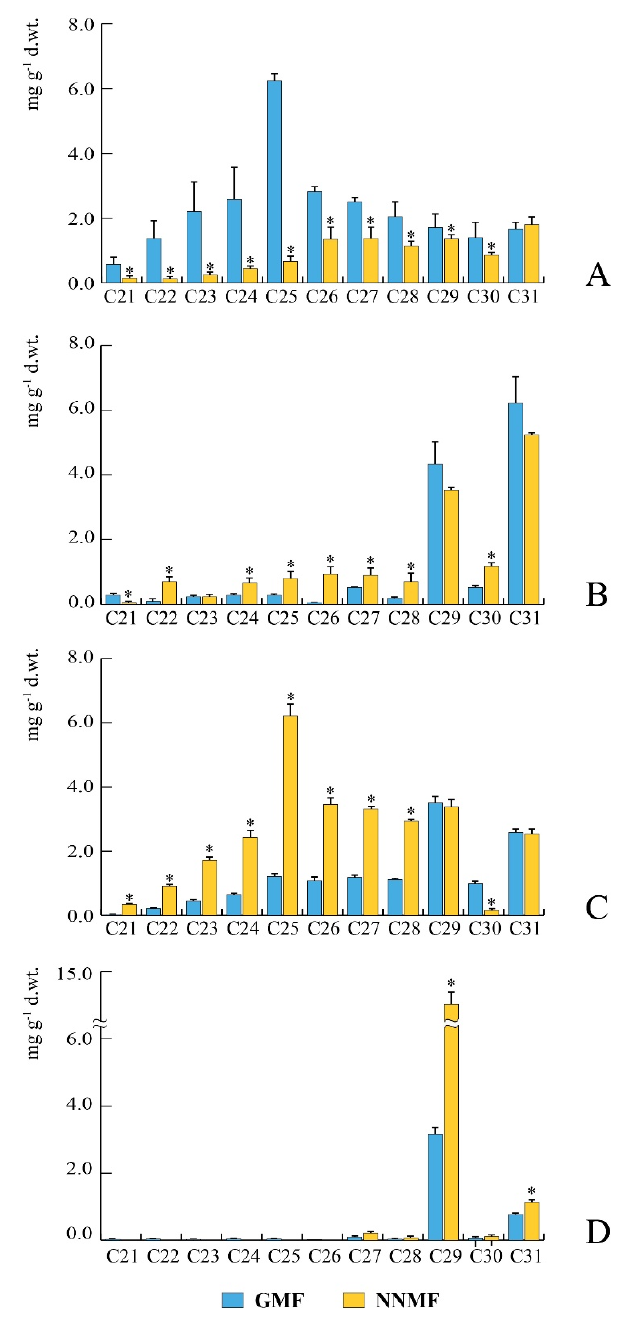
Figure 1. Surface alkane composition during Arabidopsis thaliana development upon exposure to either geomagnetic field (GMF, blue bars) or near-null magnetic field (NNMF, yellow bars). ( A ), rosette developmental stage, 15 days old plants. ( B ), bolting developmental stage, 21 days old plants. ( C ), flowering developmental stage, 30 days old plants. ( D ), seed-set developmental stage, 35 days old plants. Bars represent standard deviation. *, significant ( p < 0.05) differences between NNMF and GMF plants.